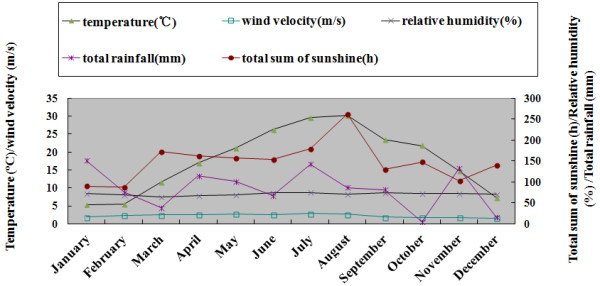
The monthly data for meteorological variables in Suzhou, China.